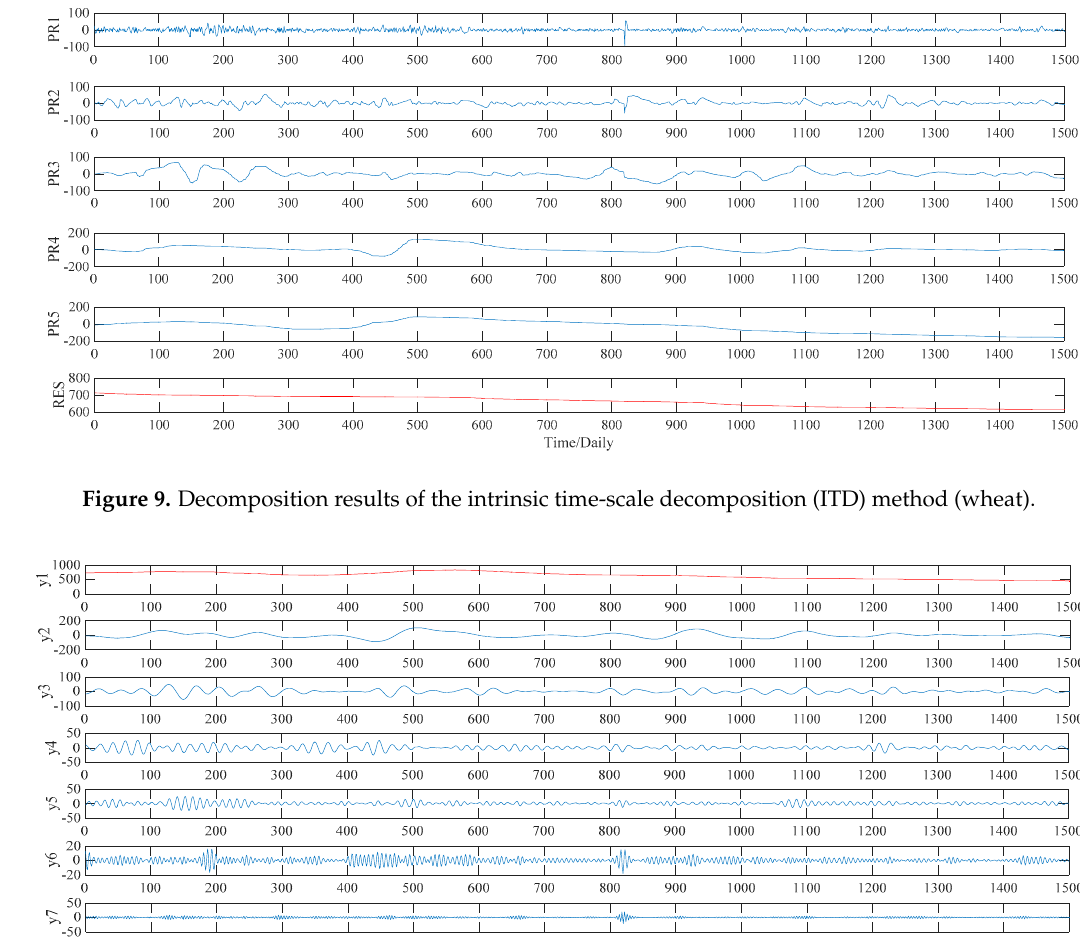
Figure 8. Decomposition results of the WPT method (wheat).